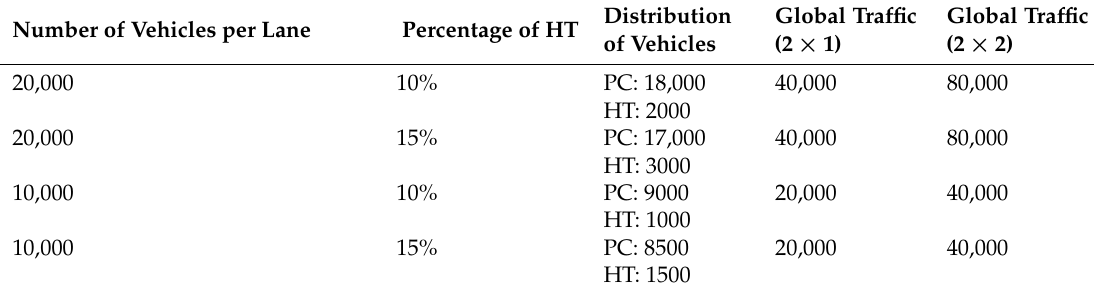
Table 3. Traffic classes.